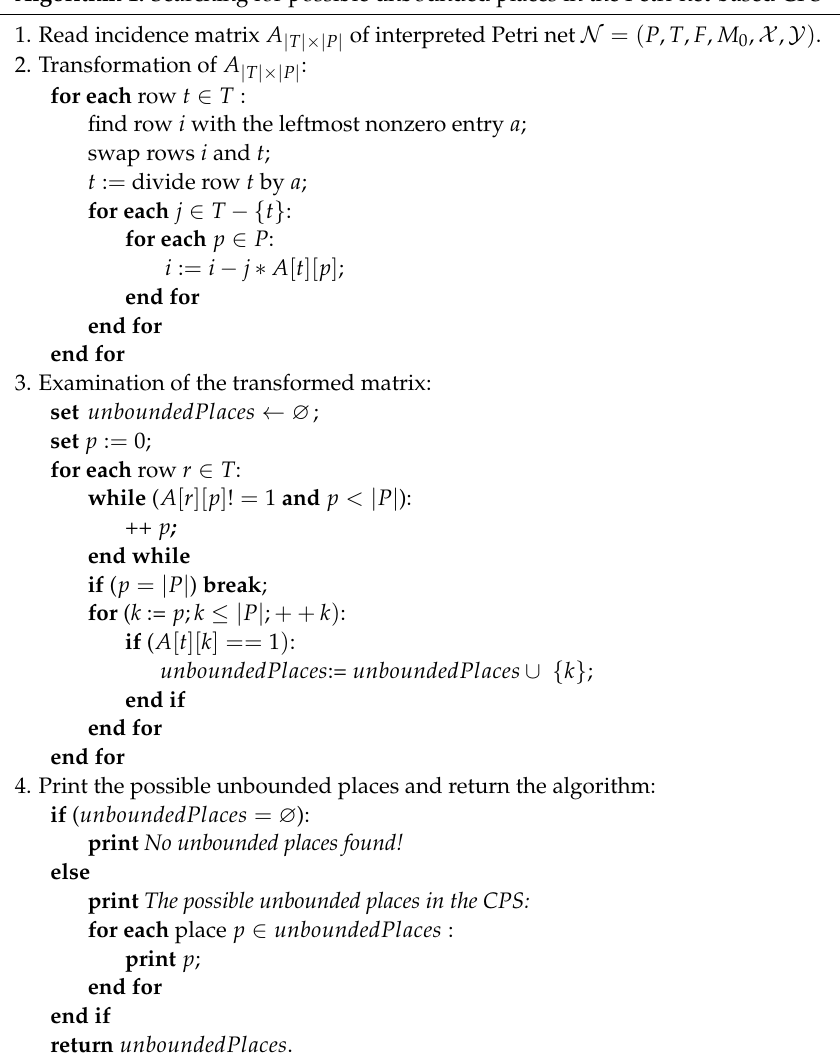
Algorithm 1: Searching for possible unbounded places in the Petri-net-based